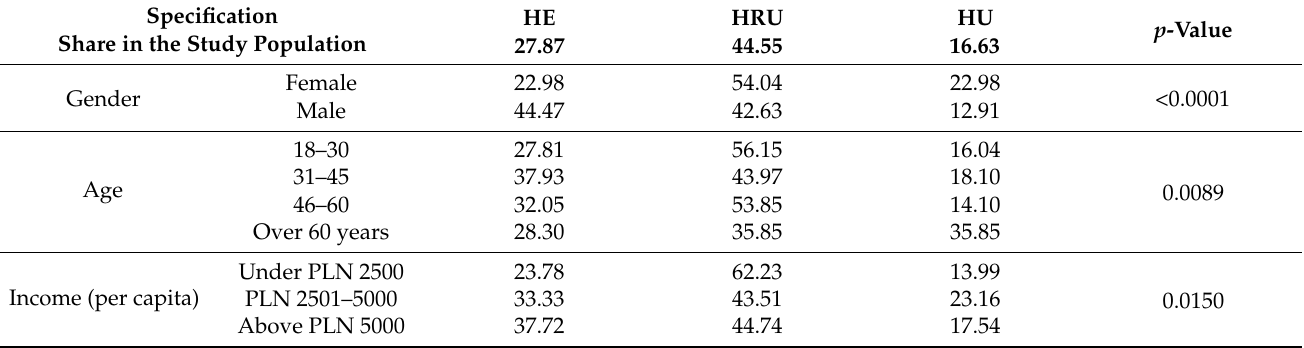
Table 3. Clusters characteristics by demographic and economic features (n = 487, data in %).